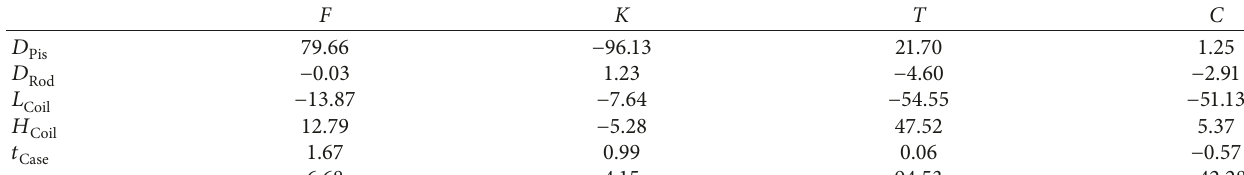
Table 4: Correlation coefficient matrix (%).